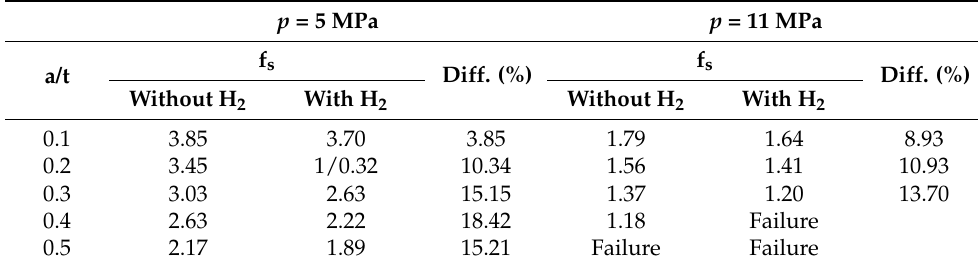
Table 6. Safety factor (f s ) values for different relative crack depth ratios (a/t = 0.1 to 0.5), with and without HE and for 2 different gas pressures ( p = 5 MPa and 11 MPa).